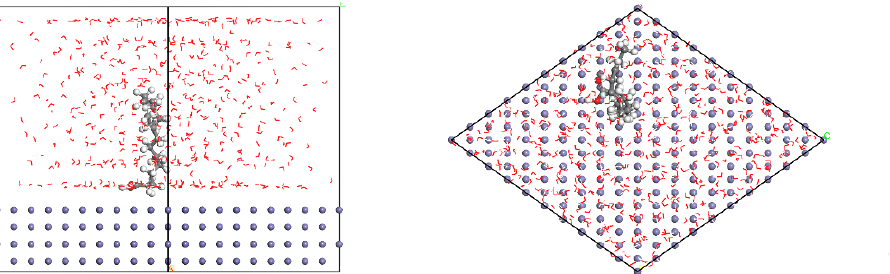
Figure 15. The adsorption configuration of α -linolenic acid molecule on Fe (110) surface.